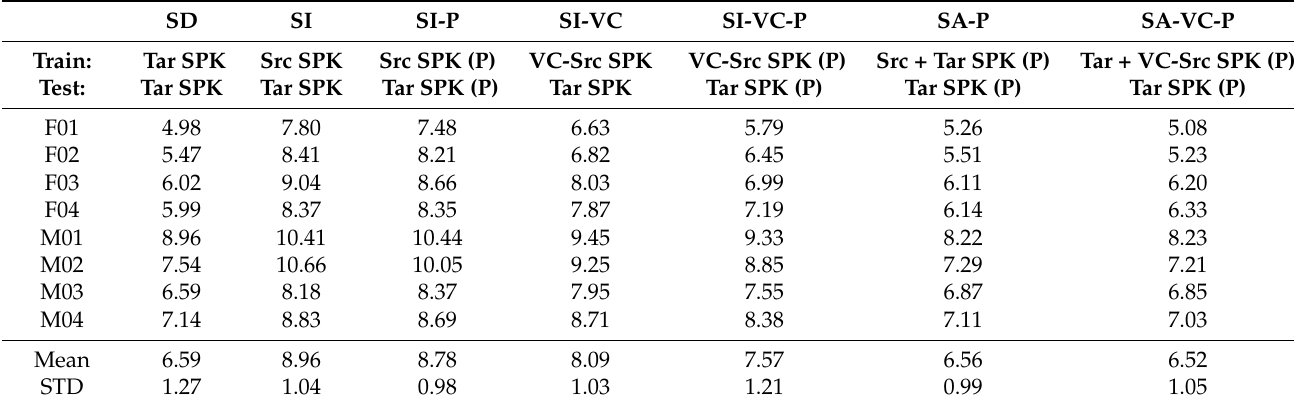
Figure 4. Average MCDs of the experiments in this study. SD : speaker-dependent. SI : speaker- independent. SI-P speaker-independent with Procrustes matching. SI-VC : speaker-independent ATS with voice conversion. SA : data from targets speakers were directly added to the ATS training set. Table 3. MCD of ATS experiments on each